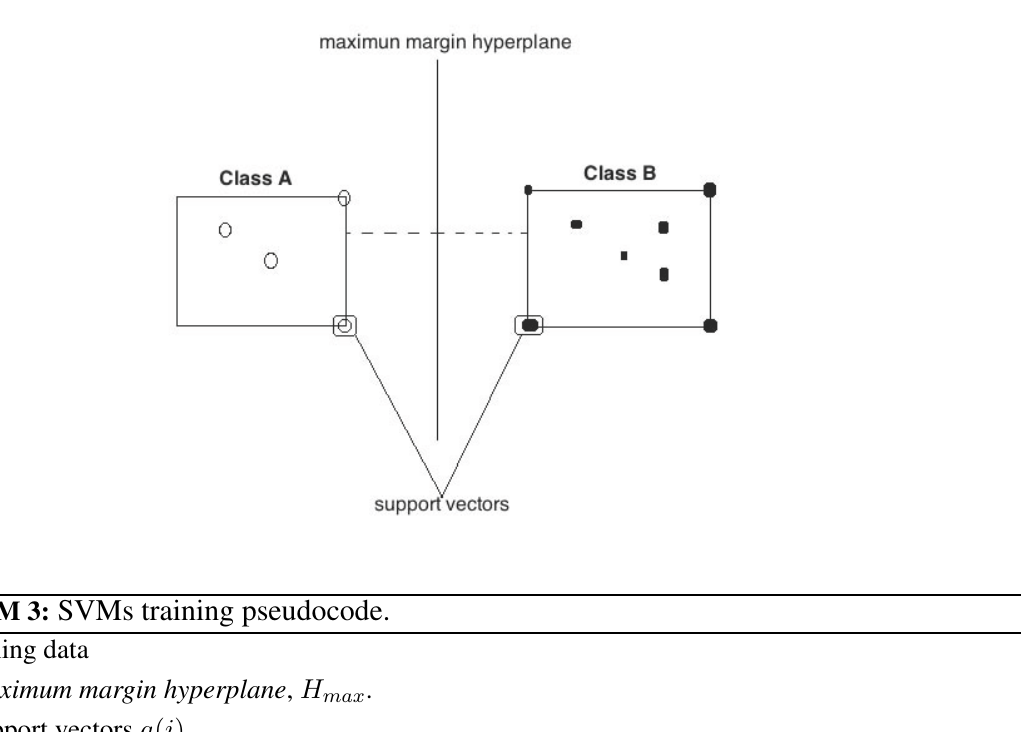
Figure 3. SVMs maximum margin hyperplane [18].